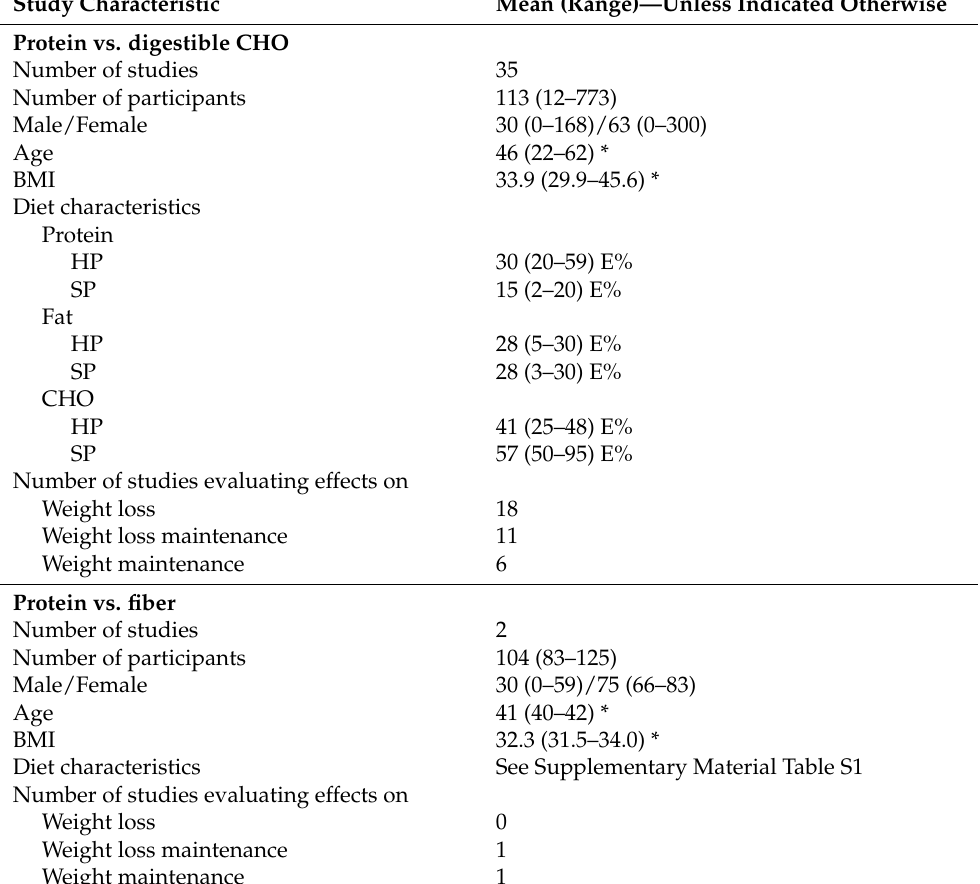
Table 2. Key study features and participant characteristics of studies included in this systematic